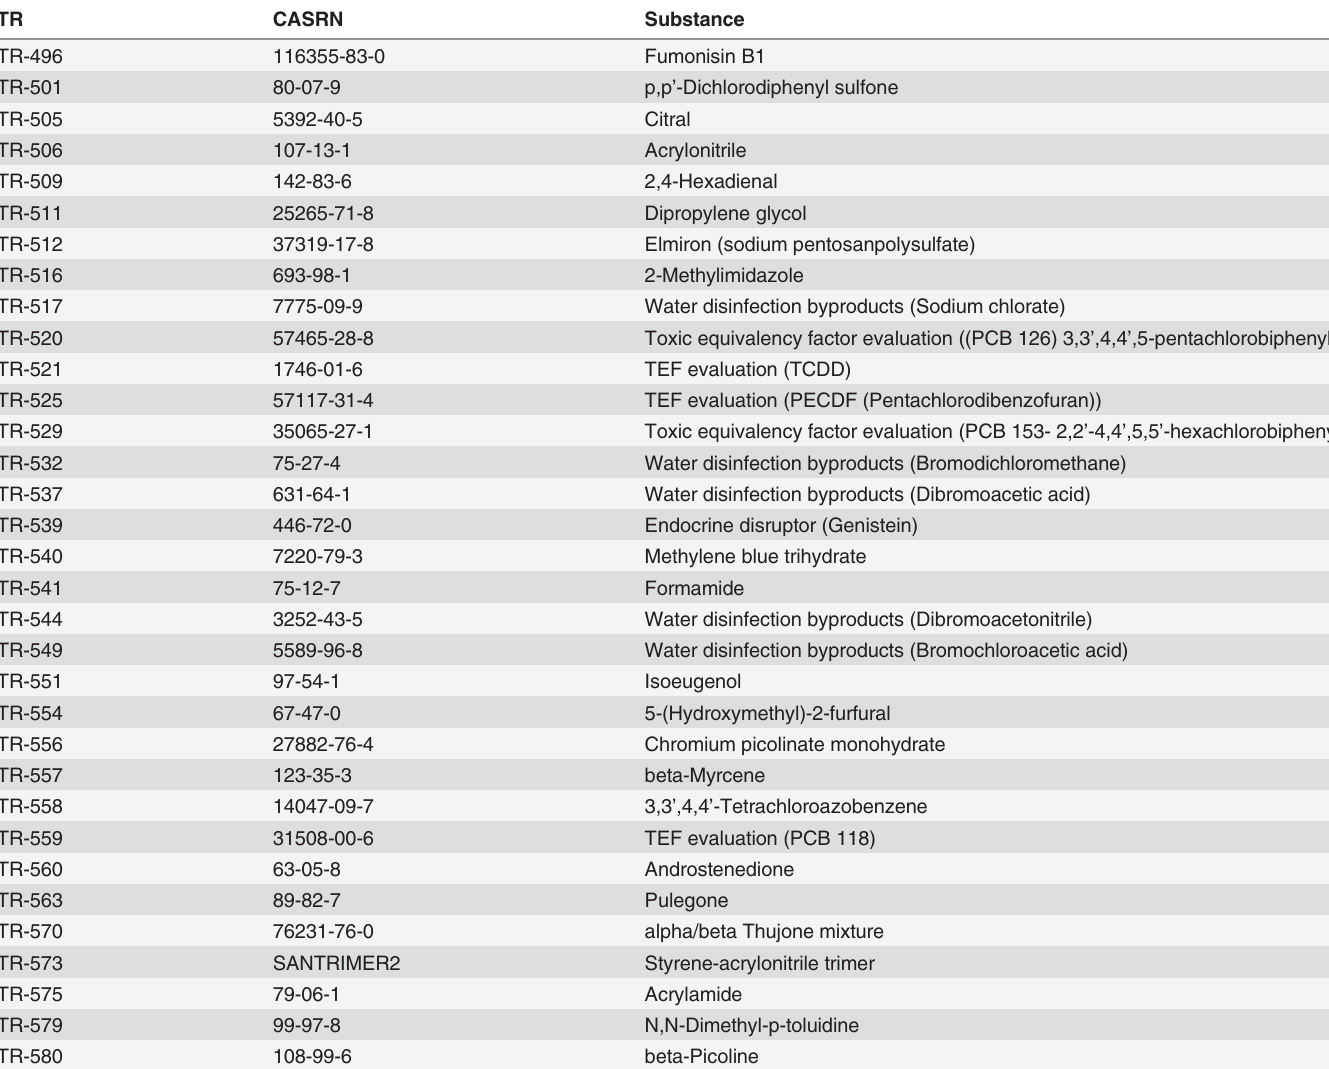
were either not suitable for the present analysis, e.g., the Chemical Abstracts Service Registry Number (CASRN), or their attribute values were correlated with certain TRs, e.g., the strain, because some strains were employed only in specific TRs. Filtering of Animal Data . All 116673 animals were evaluated for inclusion in the analysis. Three inclusion criteria were specified on every animal. First, every animal was required to be exposed to the test substance, i.e., the attribute CO was required to be false. Second, the dose level for every animal was required to be available in the above mentioned representation, i.e., animals with missing data in the attribute DL were excluded. Third, every animal was